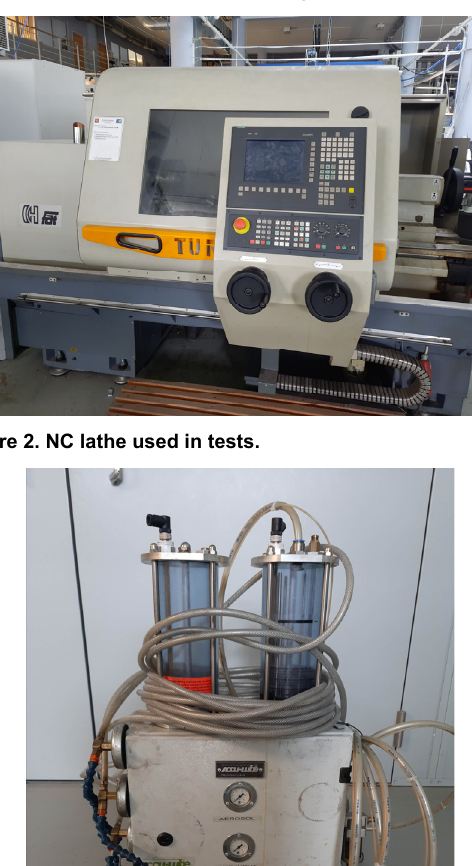
Figure 1. Polished section of investigated material.